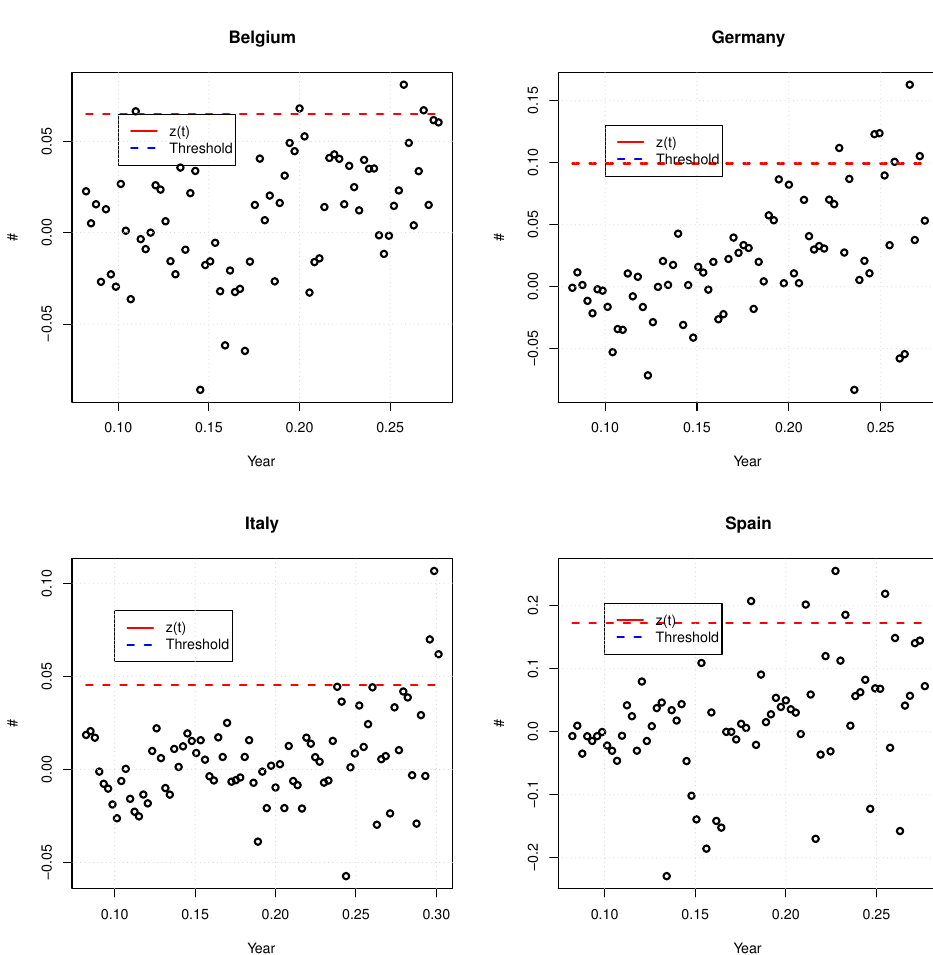
Figure 6. Plot of Z k time series for Belgium, Germany, Italy and Spain. The threshold is calculated with q =